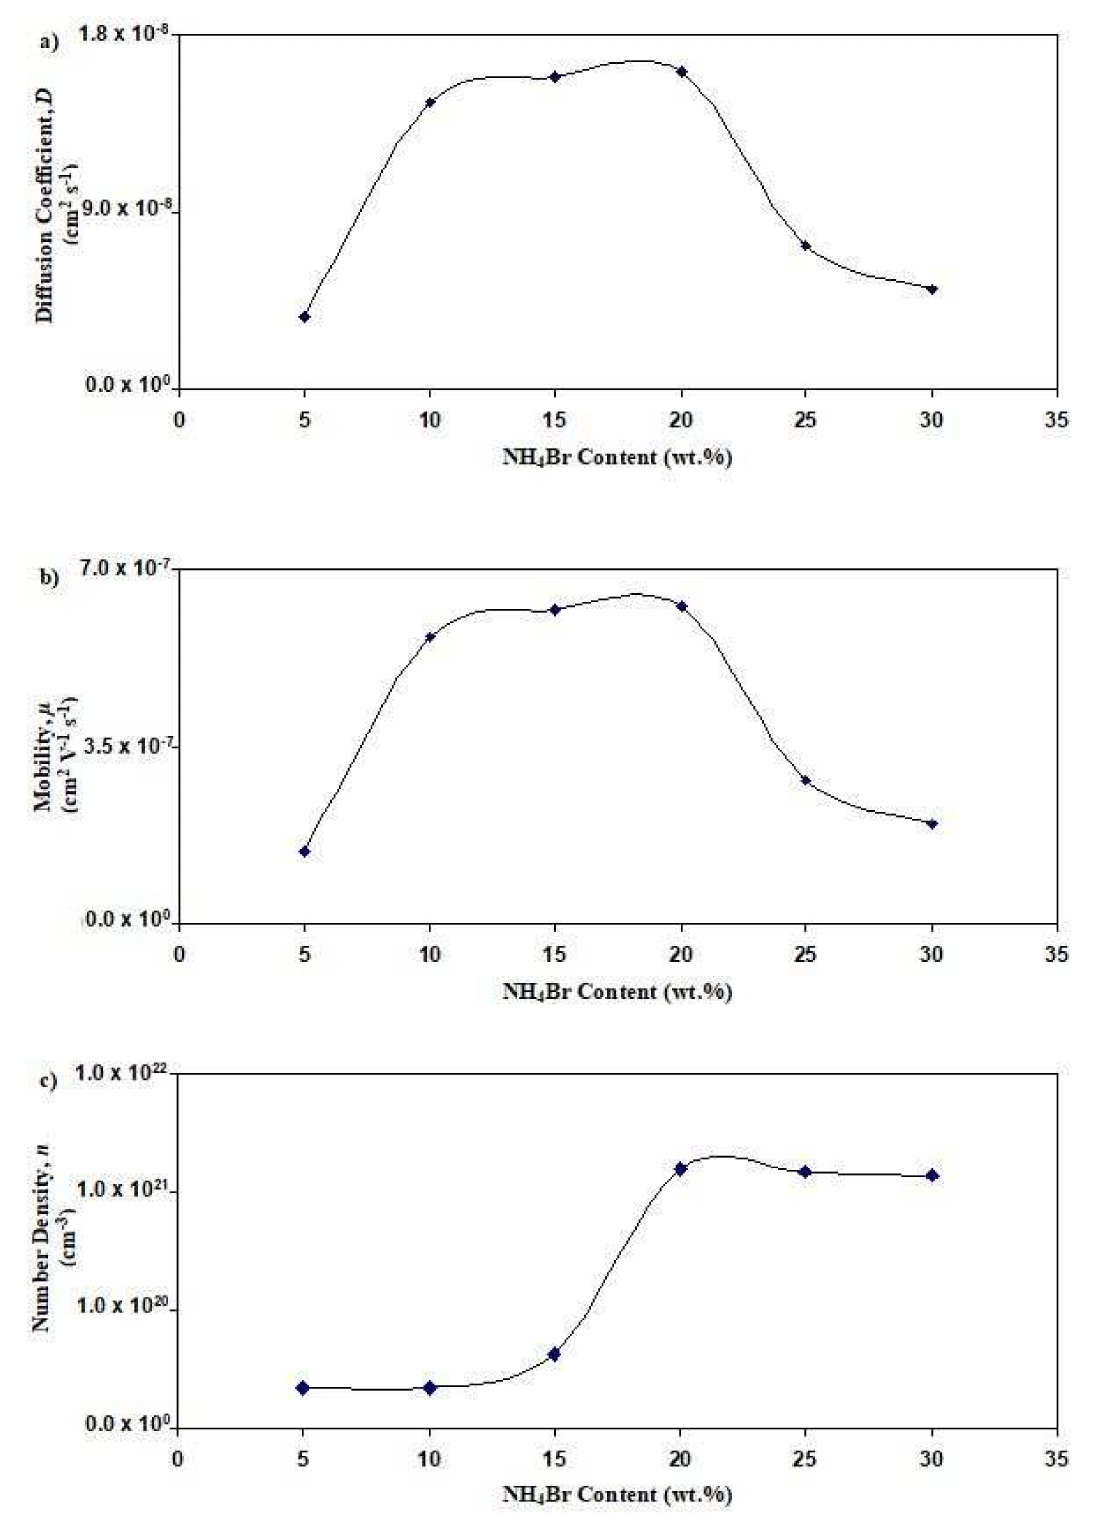
Figure 9. Graph of ( a ) D , ( b ) µ , and ( c ) n for the salted electrolytes at room